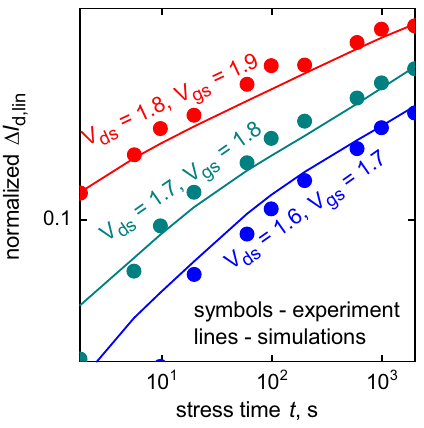
Figure 4. Experimental and simulation ∆ I d,lin ( t ) degradation traces are in good agreement for all three stress conditions. The data are from